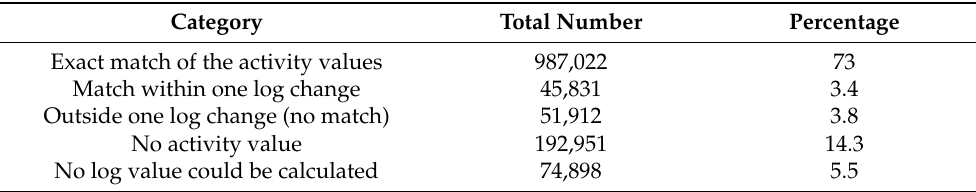
Table 1. Analysis of activity check annotation for bioactivities in at least two source databases. Percentage values refer to bioactivities that were found in at least two sources.